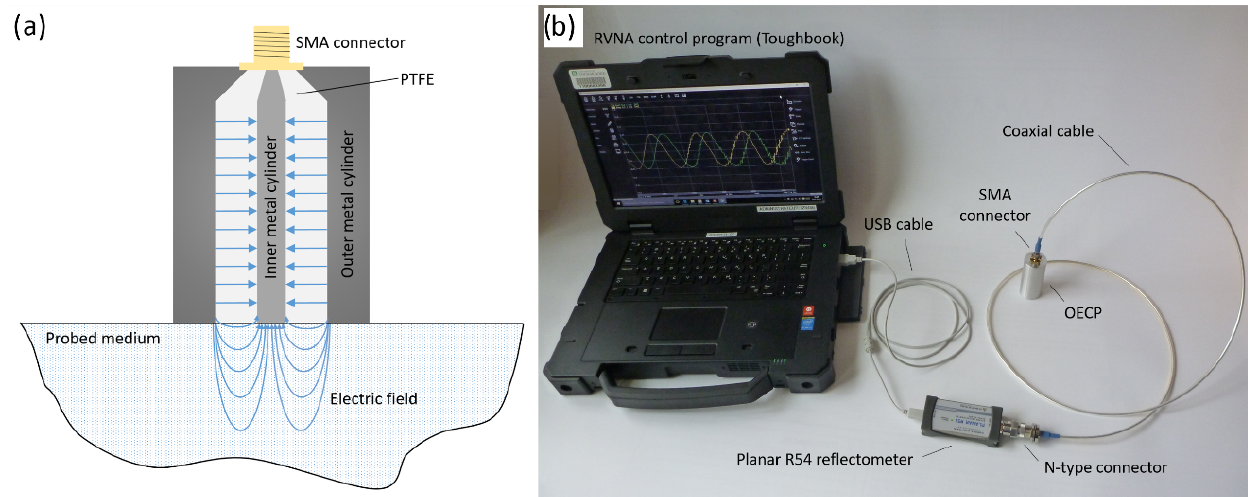
Figure 2. (a) Diagram of the electrical field produced by the open-ended coaxial probe. (b) Open-ended coaxial probe kit for permittivity measurement. The reflectometer manufacturer provides the RVNA control program. An SMA N cable is required to connect the probe to the Planar R54